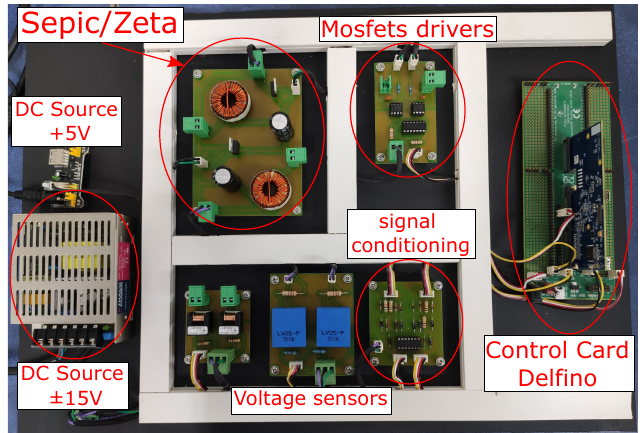
Figure 21. Charger/discharger prototype.